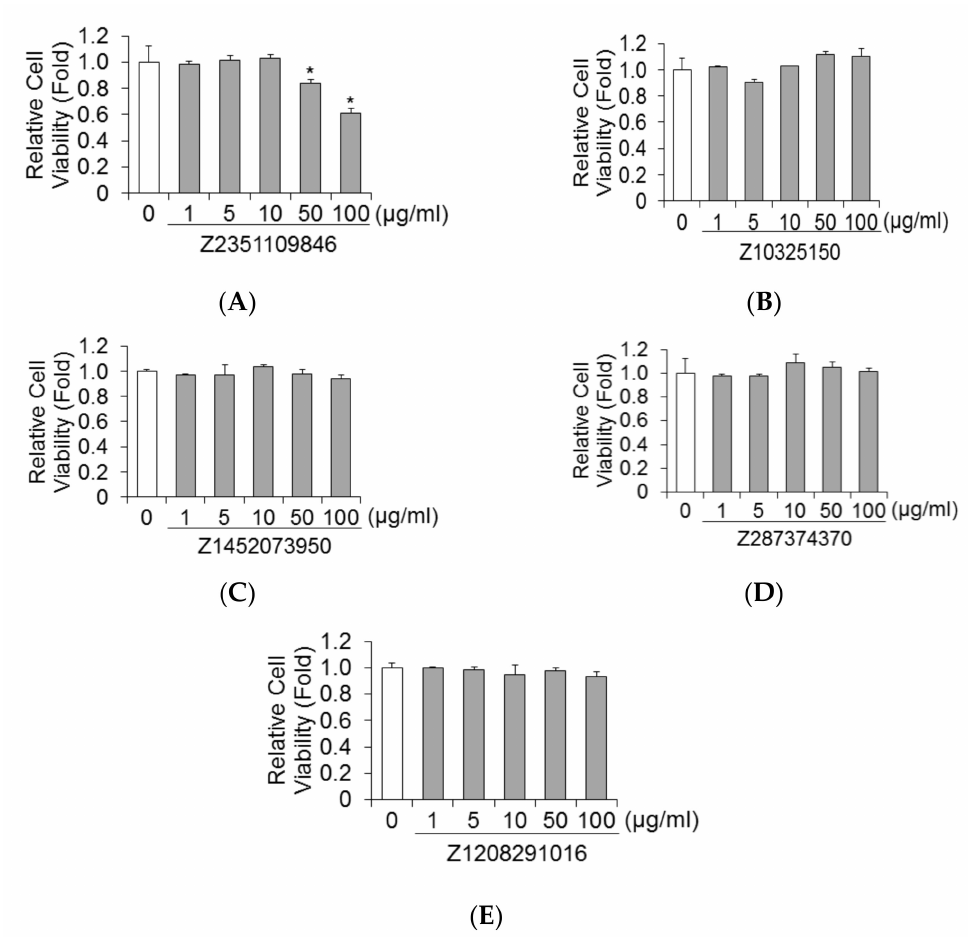
Figure 4. Effects of Z2351109846, Z10325150, Z1452073950, Z287374370, and Z1208291016 on cell viabilities of Huh7 cells. Cell viabilities of Huh7 cells treated with Z2351109846 ( A ), Z10325150 ( B